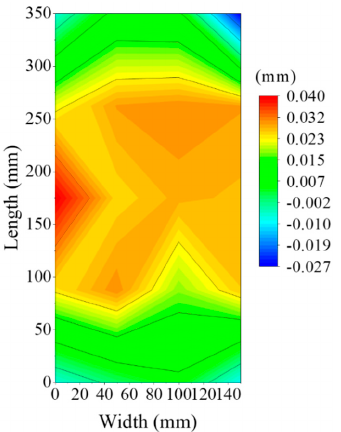
Figure 14. The bottom distortion difference between part 2 and part 4 in blank 3 (A2 = 2 mm).